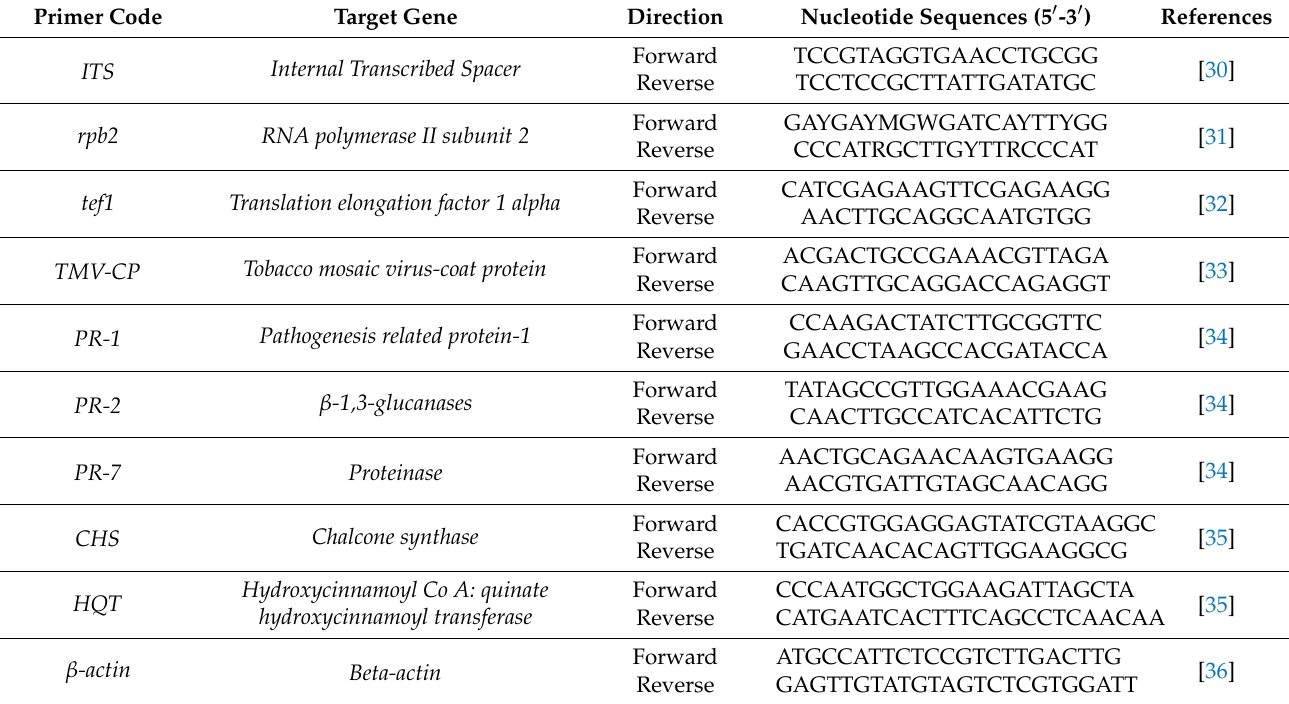
Table 1. Sequences of primers used in this